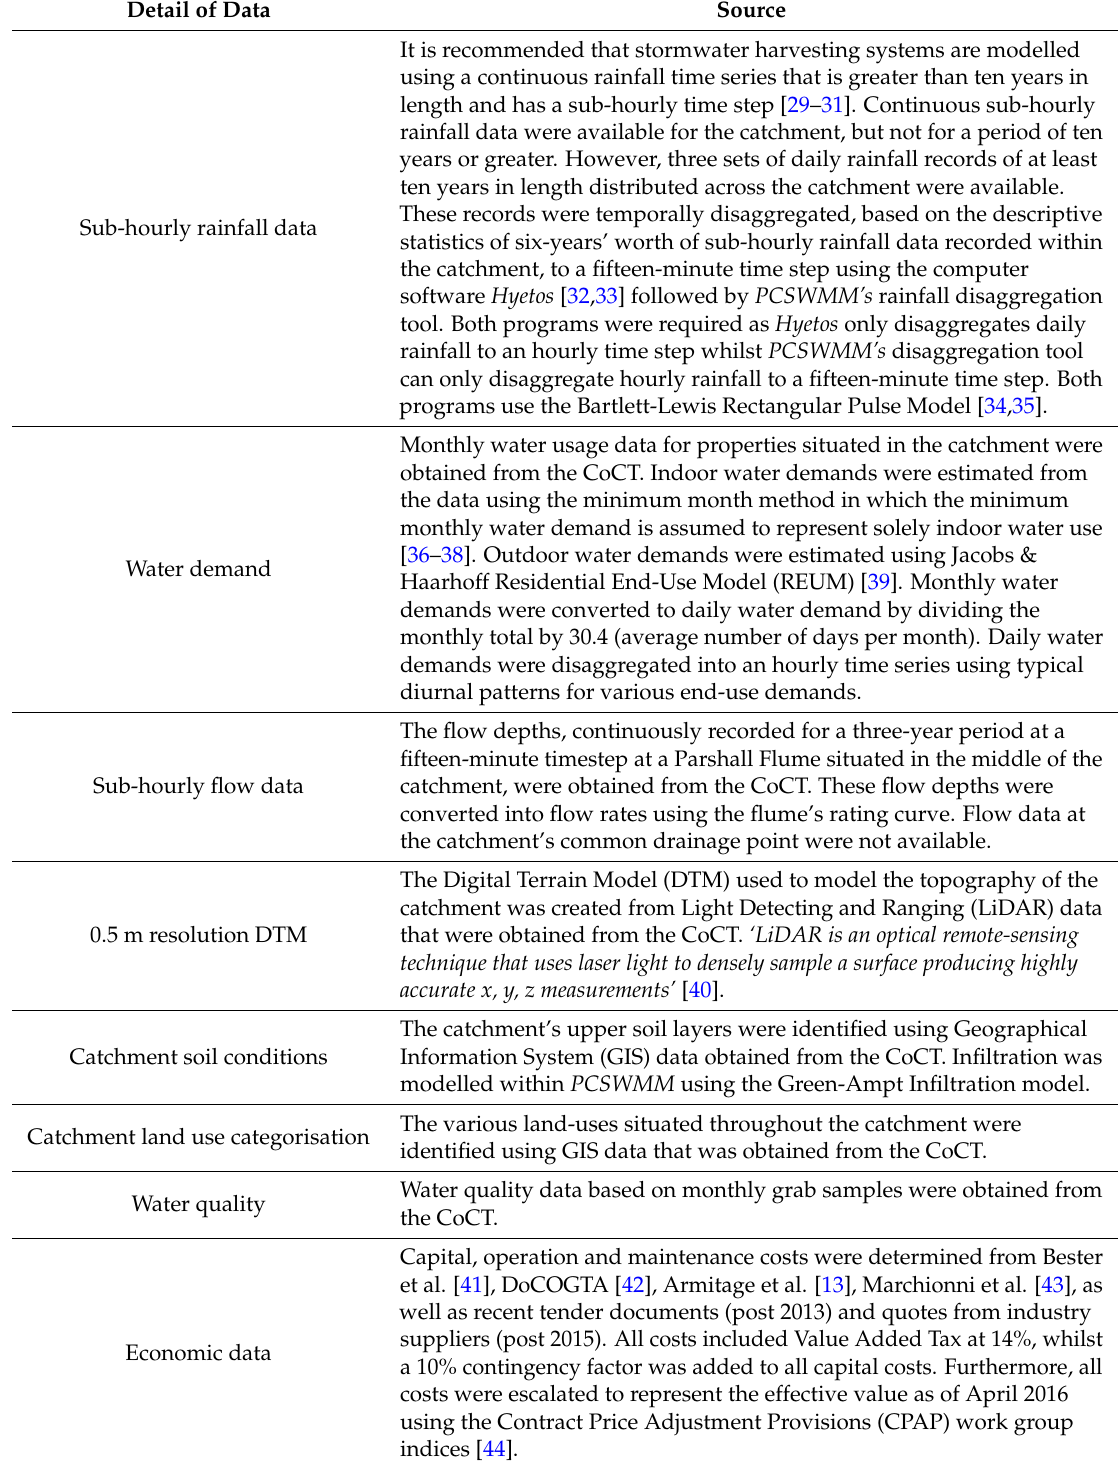
Table 2. Data used to model stormwater harvesting